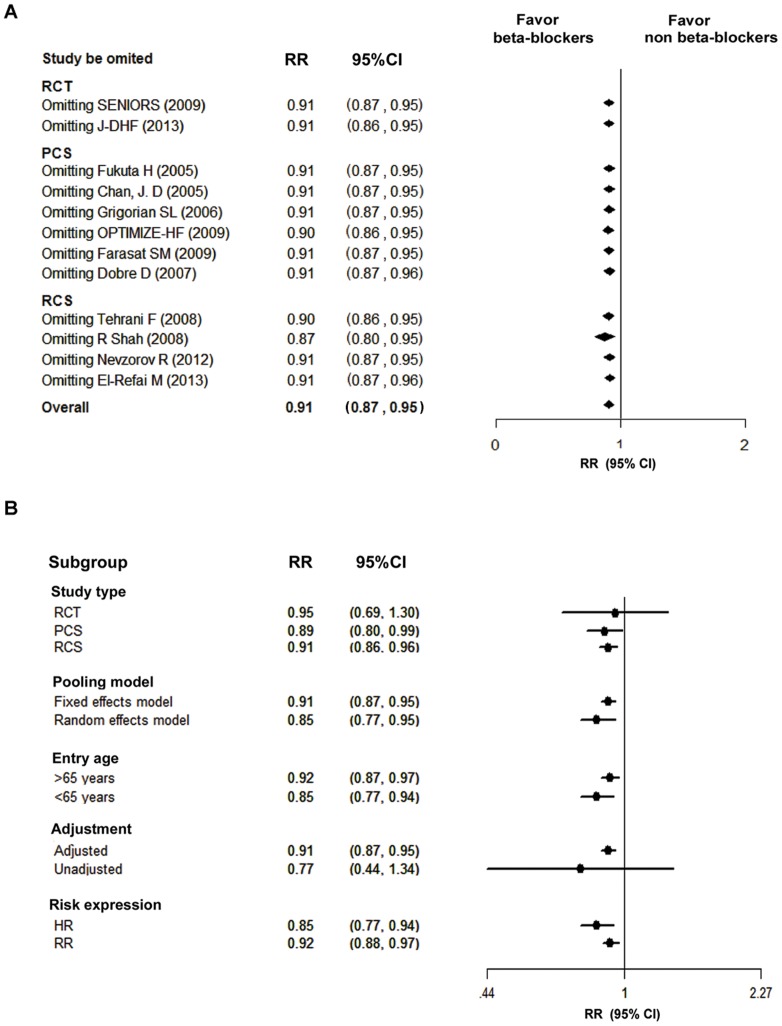
Sensitivity analyses.A: Leave-one-out analysis; B: Subgroup analyses. The adjusted subgroup was those studies that performed multivariate analysis to obtain Relative Risks, and the provided RRs were directly used for pooling analysis. The unadjusted subgroup group was those studies without performing multivariate analysis, and the RRs were calculated by using the primary data. CI, confidence interval; HR, hazard ratio; LVEF, left ventricular ejection fraction; PCS, prospective cohort study; RCS, retrospective cohort study; RCT, randomized controlled trial; RR, relative risk.